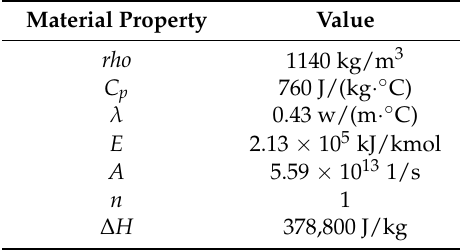
Table 1. Thermophysical and thermochemical properties of E-Glass vinyl ester used in calculations [28]. Material